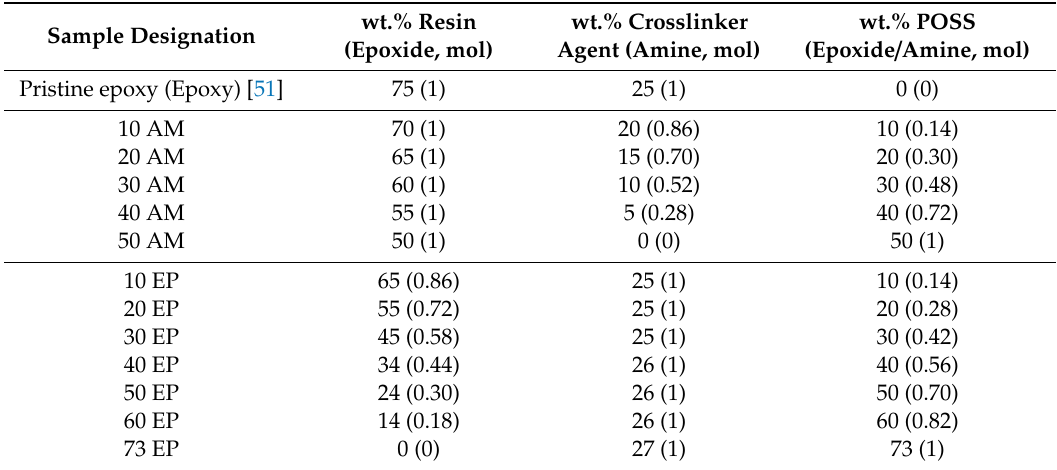
Table 1. Composition of epoxy–polyhedral oligomeric silsesquioxane (EPOSS) nanocomposite samples.